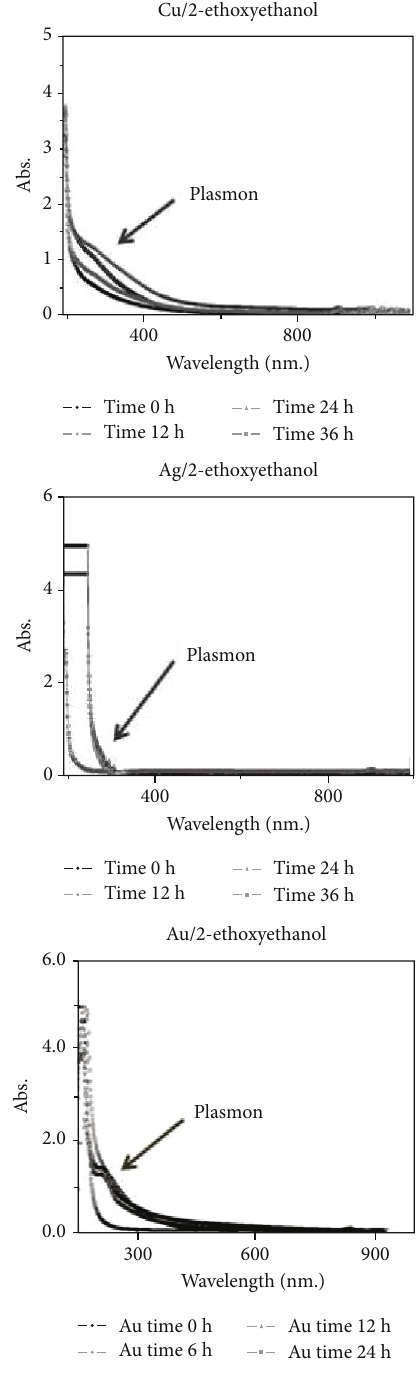
Figure 4: Cu, Ag, and Au QDs UV-VIS analysis in 2-ethoxyethanol